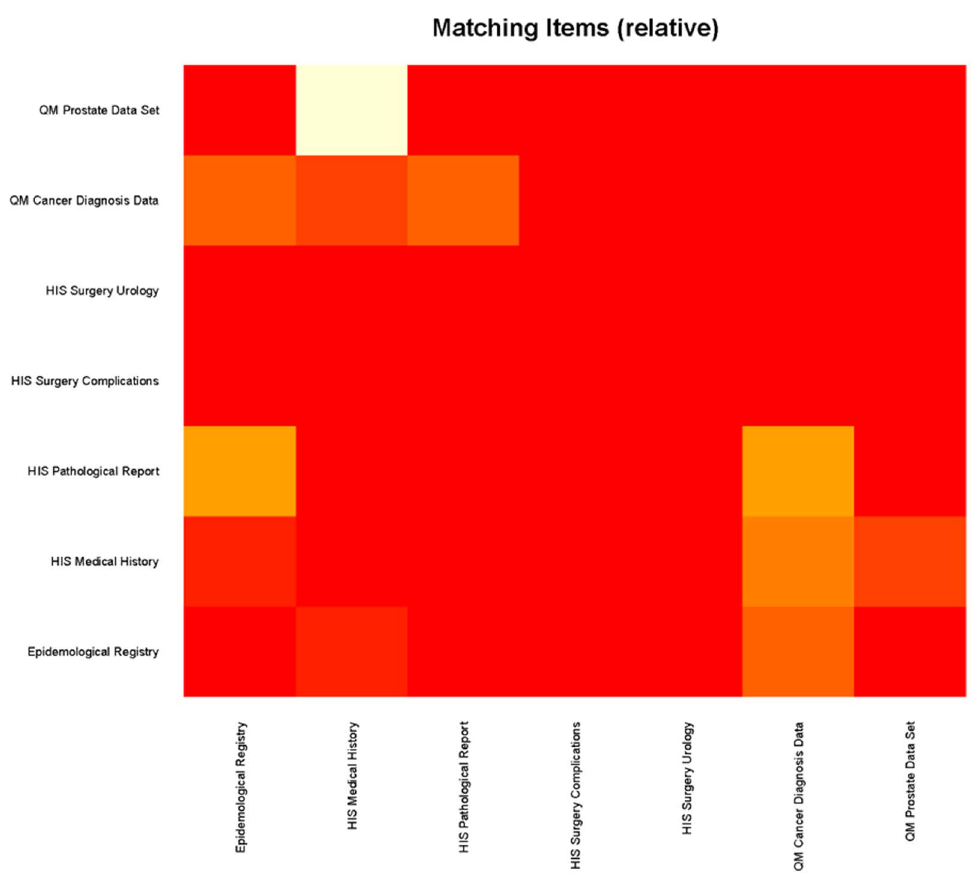
Figure 5. Grid-Image example based on the matrix with comparison results of matching items. This figure shows the relative number of matching items in a pairwise comparison. Yellow cells represent high percentages of similar items; red cells represent low percentages of matching items between the two respective forms.